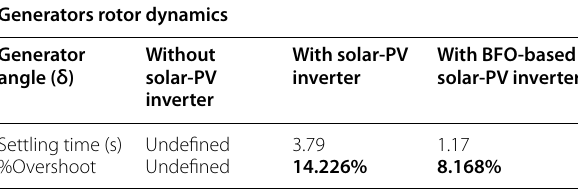
Table 3 Time domain specifications (transient state)